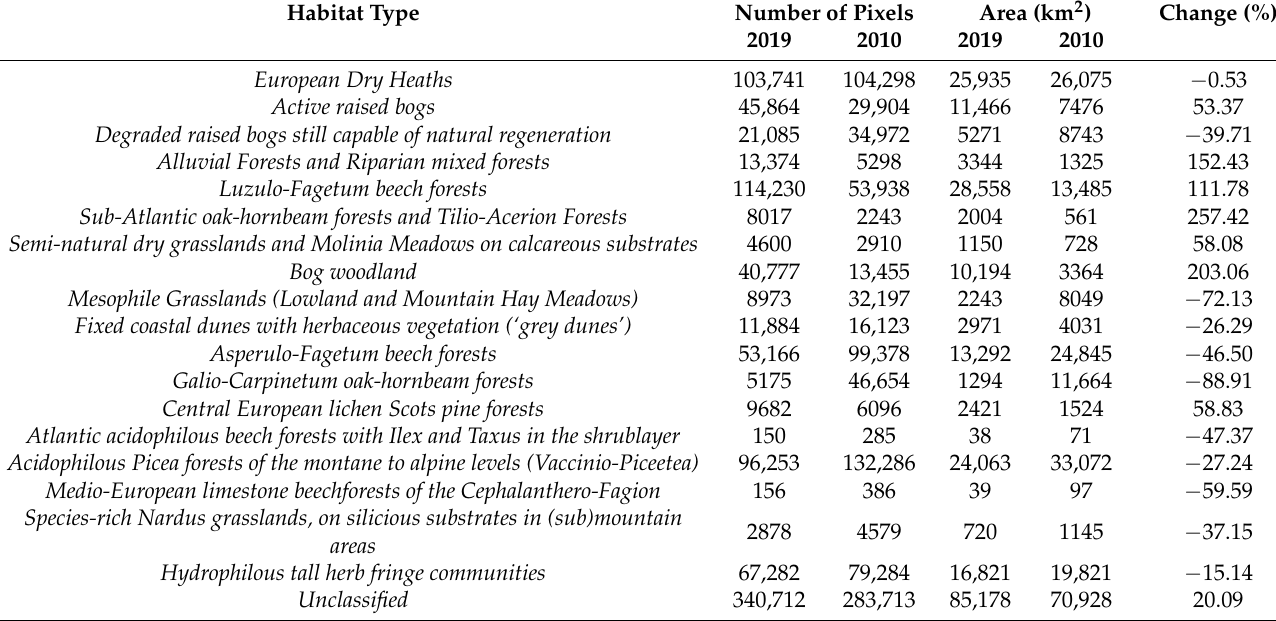
Table 4. Changes in the distribution of habitat types in Germany between 2010 and 2019 based on the final ensemble classification results after model averaging. Area of habitat types is given by the number of pixels belonging to a certain class multiplied by the pixel size (500 m 2